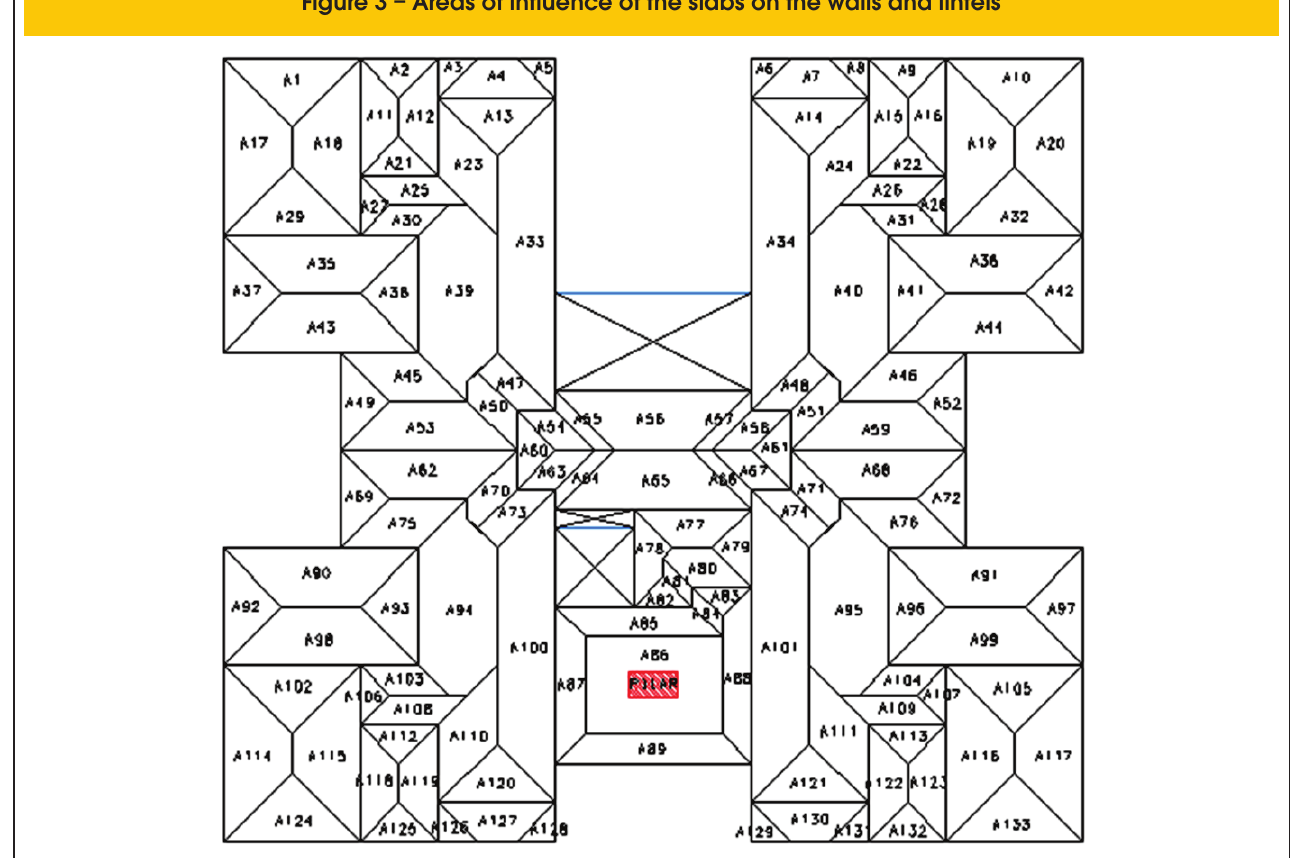
Figure 3 – Areas of influence of the slabs on the walls and